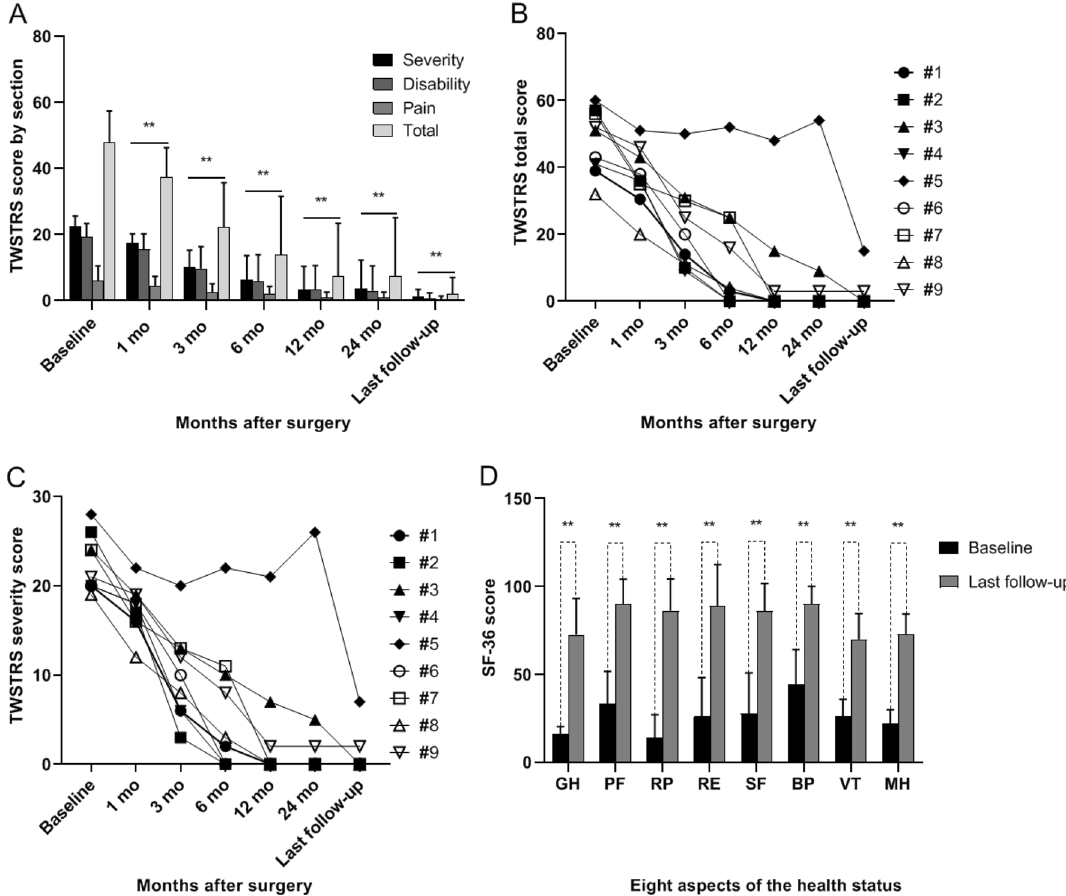
Figure 1. Mean score for TWSTRS severity, disability, pain, and total scores at various time points before (baseline) and after operation ( A ). Line graphs show individual scores of the TWSTRS total score ( B ) and severity score ( C ) at various time points before (baseline) and after operation. Mean score for the baseline and the last follow-up assessed by the 36-item Short General Health Survey ( D ). GH general health, PF physical